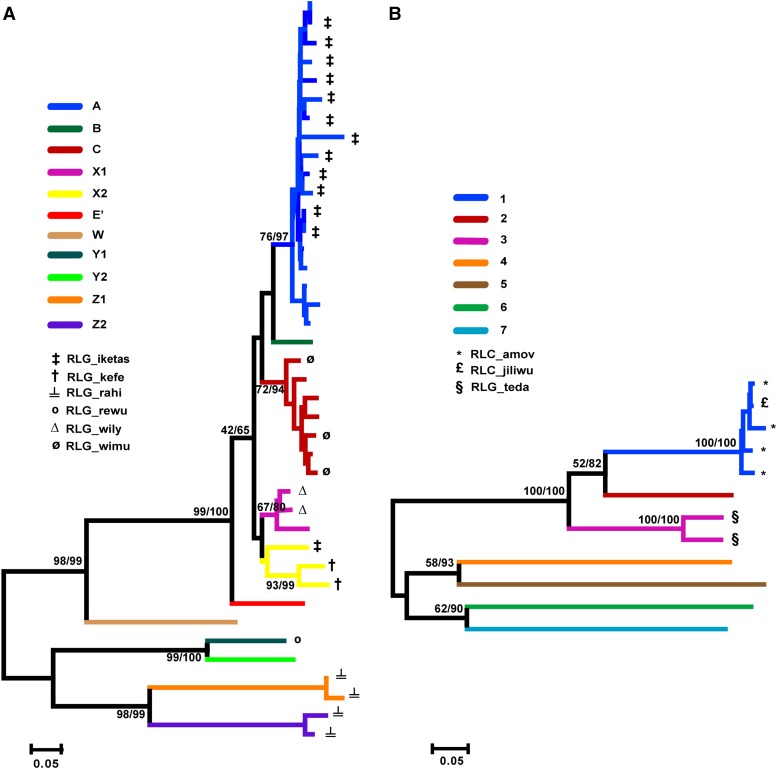
Neighbor-joining trees depicting sublineages of gypsy (A) and copia (B) elements based on 129 and 239 amino acid residues of the reverse transcriptase (RT) domain, respectively. Numbers along branches indicate bootstrap support for Maximum Parsimony/Neighbor-joining analyses. Branch colors depict different LTR retrotransposon sublineages and correspond to designations used in Ungerer et al. (2009) and Kawakami et al. (2010). Symbols at branch tips correspond to sunflower LTR retrotransposon families identified as highly abundant in Helianthus in Staton and Burke (2015).